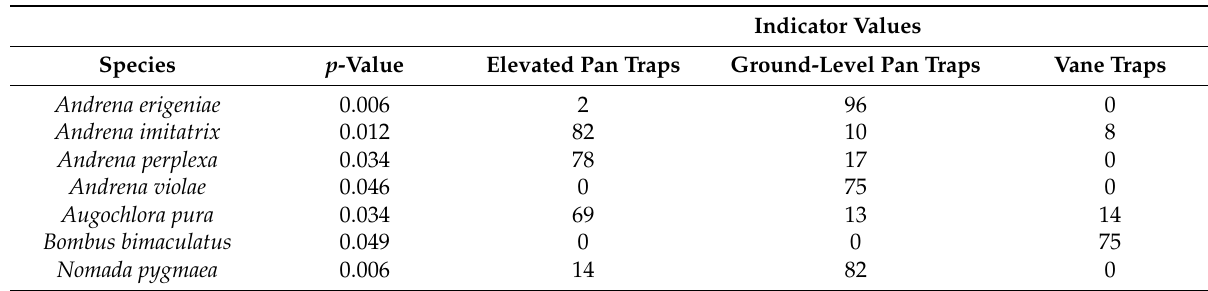
Table 3. Indicator values for species significantly associated with a particular trap type based on indicator species analysis of bees collected in oak-hickory forest in Hancock County, IL, USA, April–September